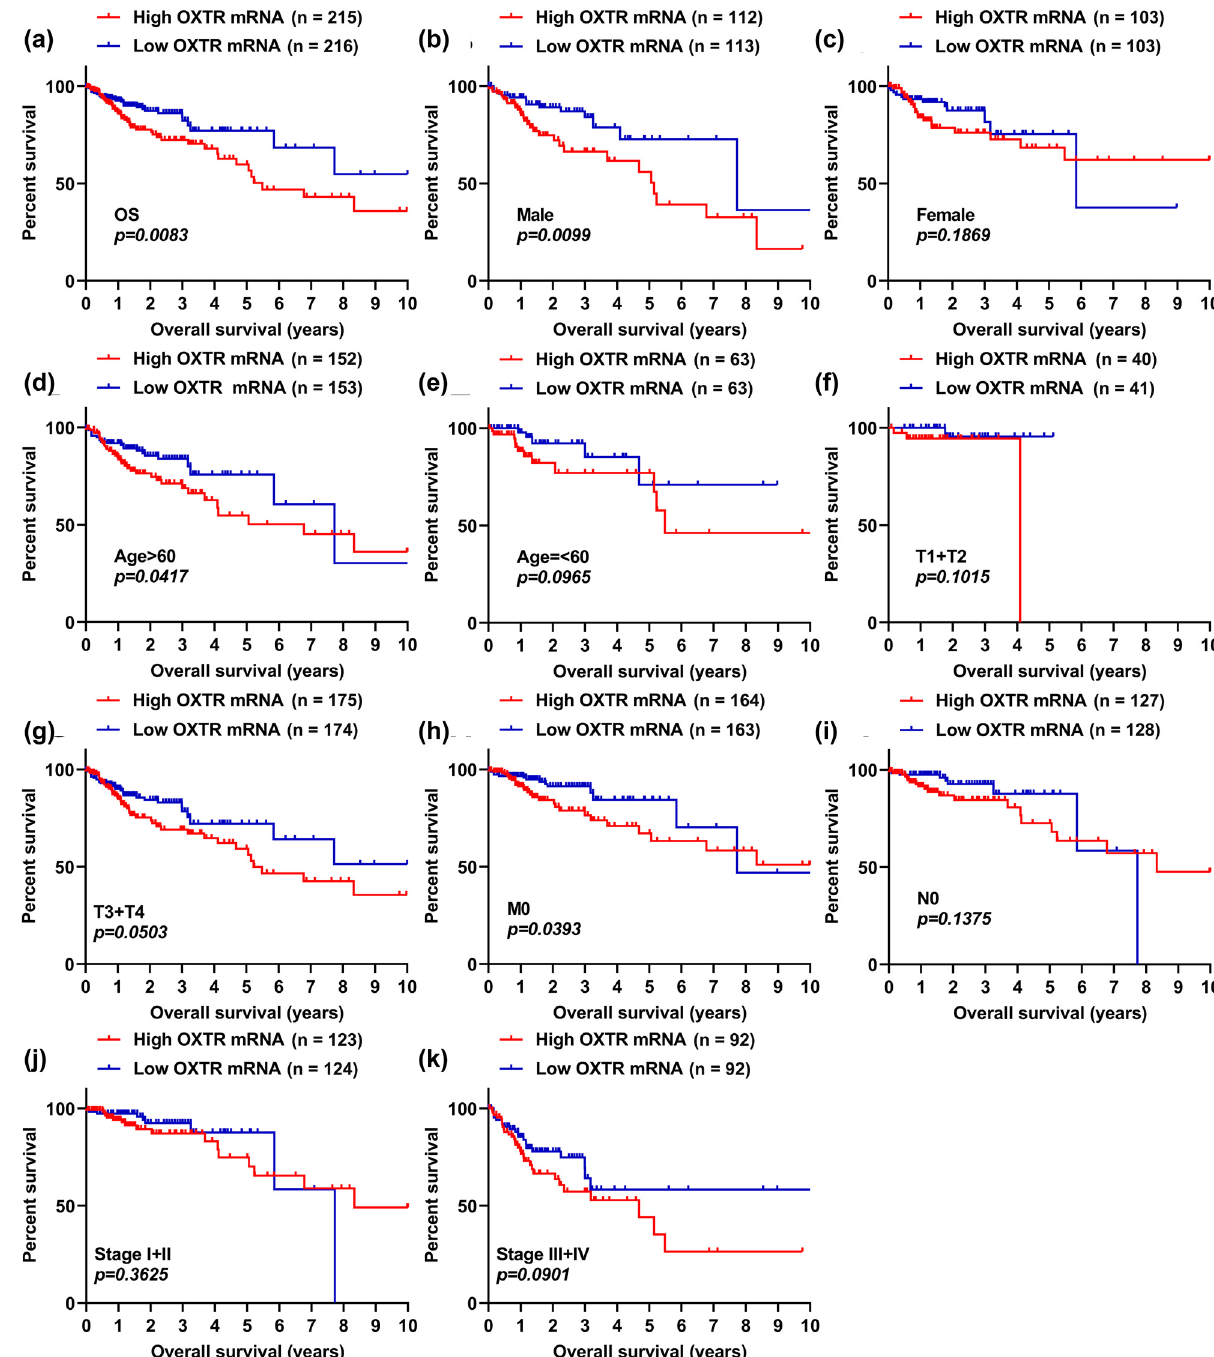
Figure 4: COAD patients with high levels of OXTR are more likely to show short OS time. ( a ) The correlation analysis between OXTR mRNA level and OS in COAD patients was performed by the KM curve. ( b – k ) KM curve analysis of male ( b ) , female ( c ) , age > 60 years ( d ) , age ≤ 60 years ( e ) , stages T1 + T2 ( f ) , stages T3 + T4 ( g ) , no metastasis ( h ) , N0 stage ( i ) , stages I + II ( j ) , and stages III + IV ( k ) patients with